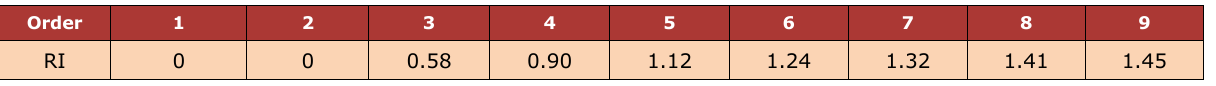
Table 2. Values of